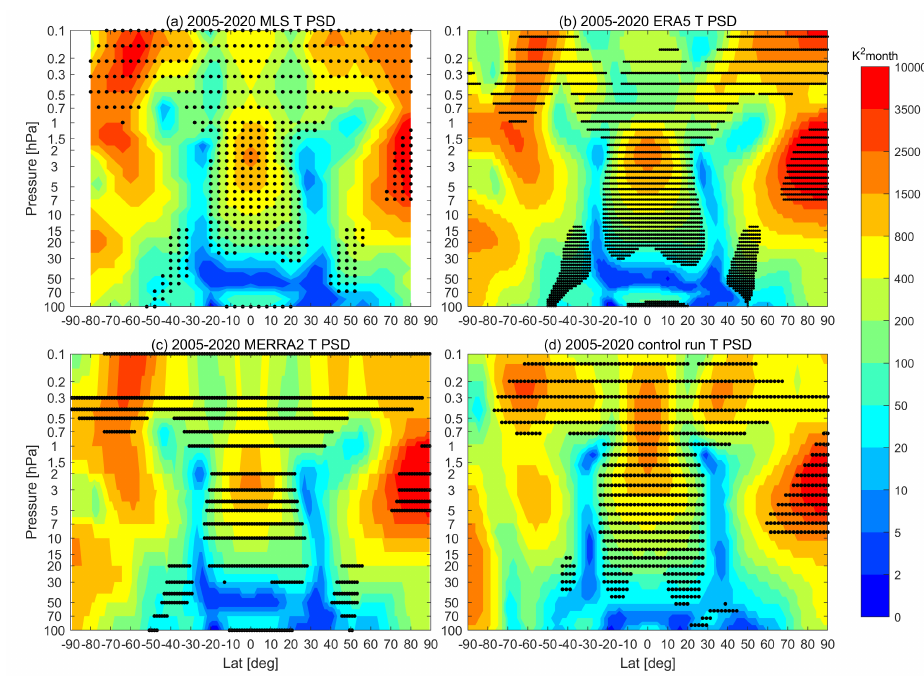
Figure 1. The power spectrum densities (PSDs) of temperature SAO based on MLS ( a ), ERA5 ( b ), MERRA2 ( c ) and model simulation ( d ) in the period 2005–2020. The dots mark the significant area with an FDR level of